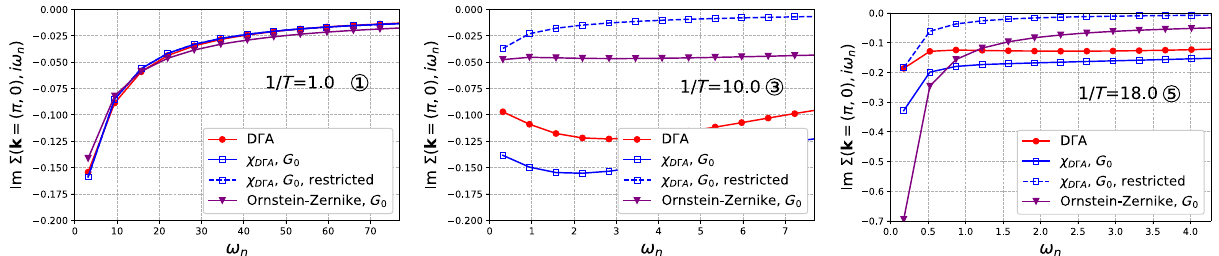
FIG. 17. Spin-fluctuation theory put to the test: comparison between the D Γ A self-energy and the result of weak-coupling spin- fluctuation theory for three temperatures corresponding to regimes ① (incoherent), ③ (metallic), and ⑤ (pseudogap). Both the full D Γ A susceptibility and its Ornstein-Zernike approximation are considered, as well as the effect of restricting the fluctuations to the long- wavelength antiferromagnetic collective mode (see